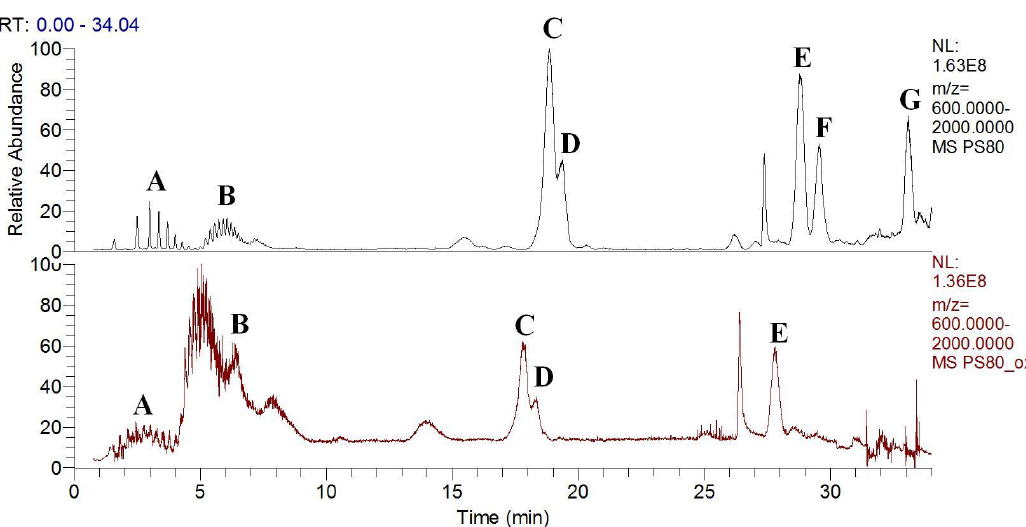
Figure 10. Total ion current (Mr ≥ 600 Da) chromatograms of non-degraded top) and degraded (bottom) PS80 after oxidation with Cu(II) and ascorbate, and following UHPLC-HRMS. The subspecies in the non-degraded PS80 were identified as: A , unesterified polyoxyethylene isosorbides, unesterified polyoxyethylenes; B , unesterified polyoxyethylene sorbitans; C , monoesters of polyoxyethylene sorbitan, polyoxyethylene monoesters; D , monoesters of polyoxyethylene isosorbide; E , diesters of polyoxyethylene sorbitan; F , diesters of polyoxyethylene isosorbide; G , triesters of polyoxyethylene sorbitan.